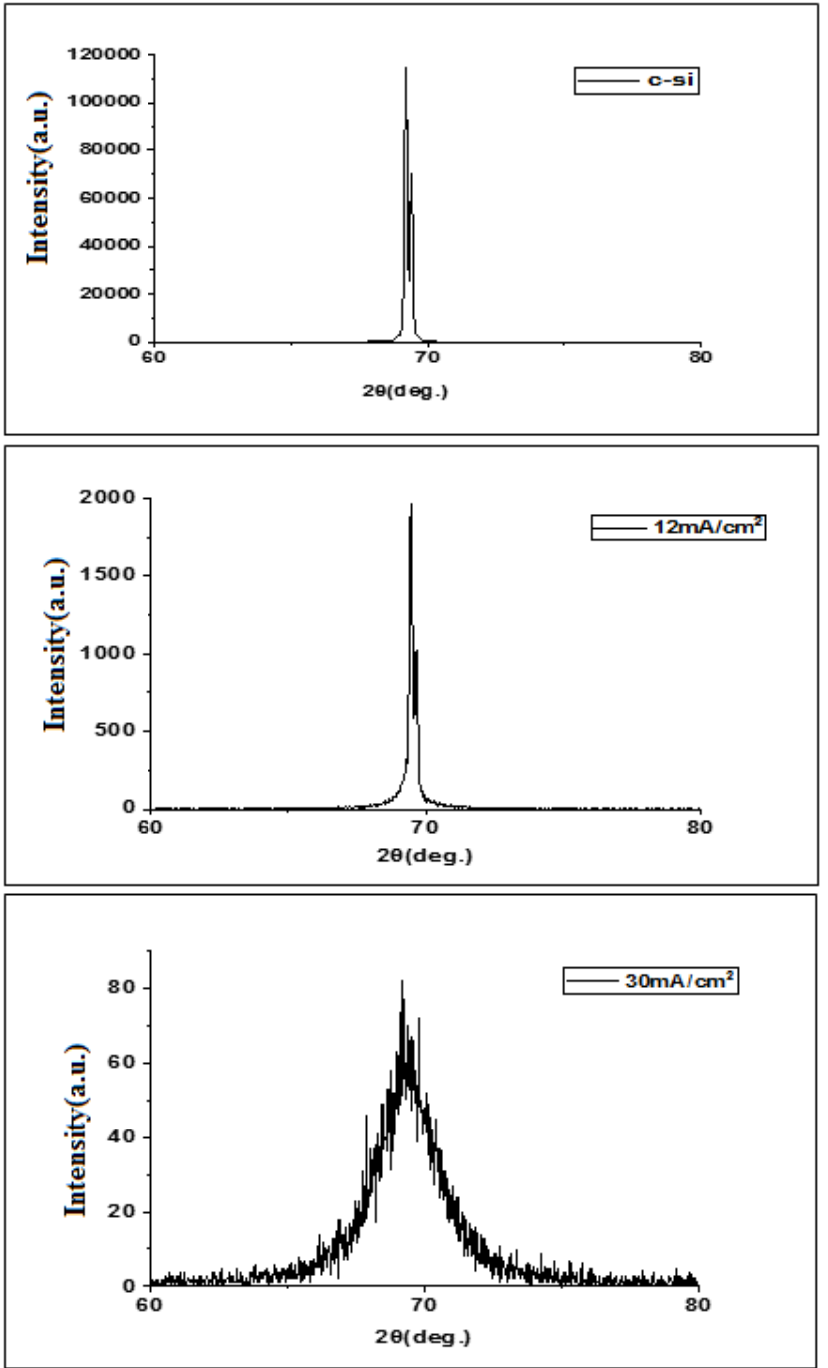
Figure 3: Illustrates the XRD diffraction patterns of the a) PSi and bulk silicon at various etching current densities of b) 12 c) 30 mA / cm 2 , HFC of 40%, and etching time 10 min